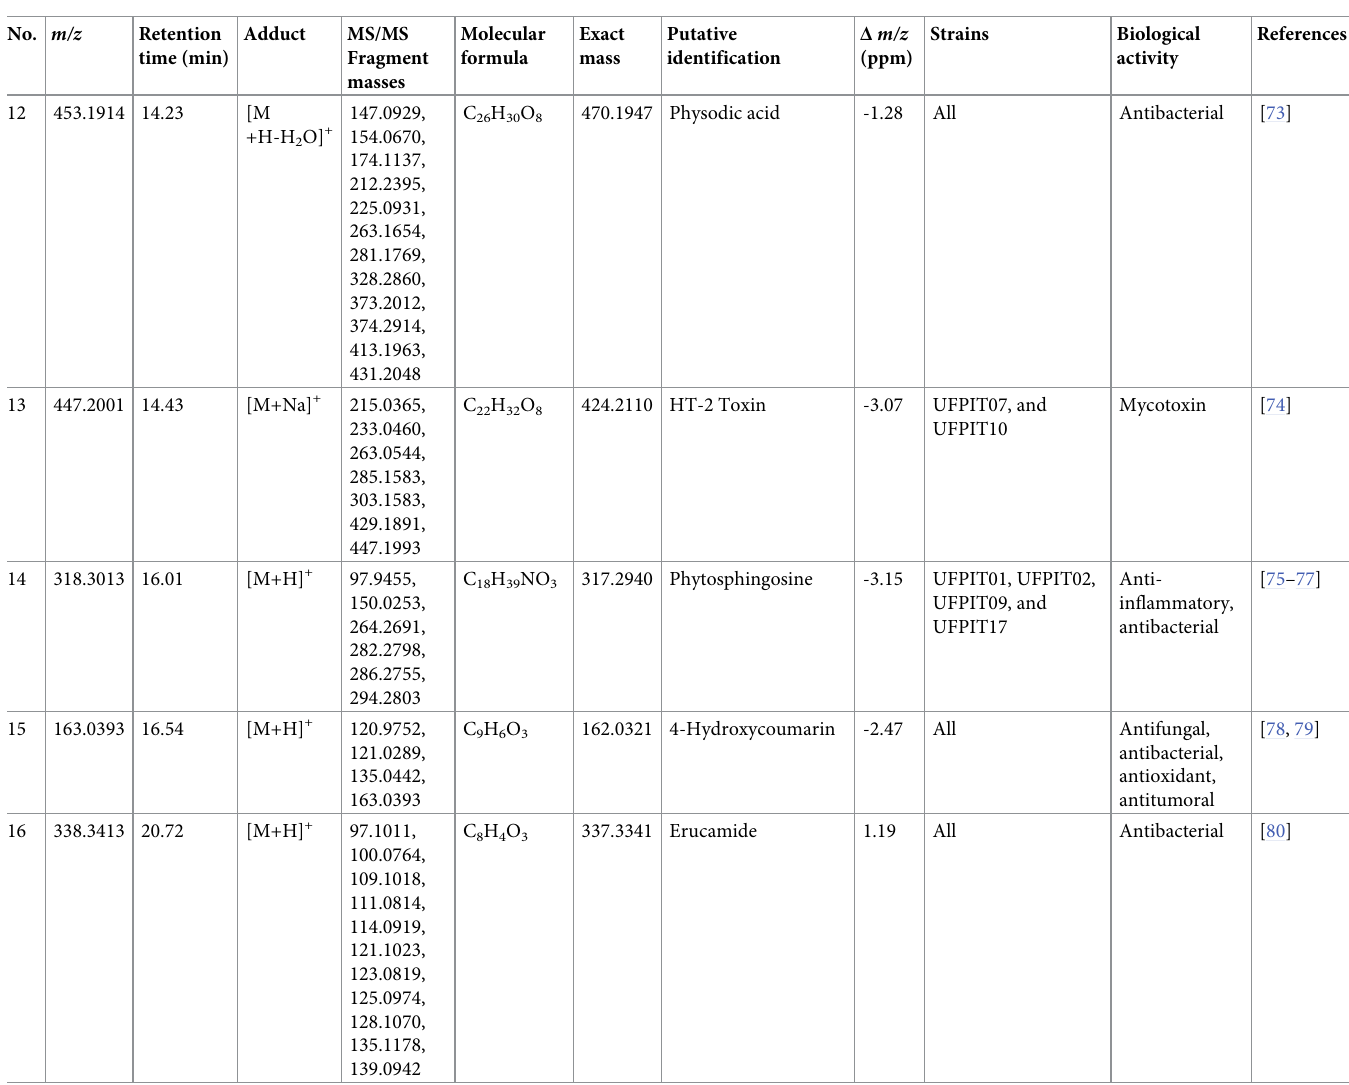
been isolated from the mycelium of Cordyceps sinensis [54]. The metabolite of m/z 118.0863 [M+H] + was detected in all Trichoderma spp. isolates and identified as glycine-betaine (Table 1, metabolite 2), presenting in the MS/MS spectrum the fragment of m/z 59.0705 corre- sponding to (CH ) N + [55]. Betaines are naturally occurring metabolites fundamental to the 3 3 mitigation of osmotic stress in plants and macro- and microorganisms [55]. The metabolite of m/z 138.0553 [M+H] + was identified as trigonelline (Table 1, metabolite 3) and was detected in T . longibrachiatum (UFPIT02), Trichoderma sp. T2 (UFPIT05), T . koningiopsis (UFPIT07), Trichoderma sp. T5 (UFPIT11), Trichoderma sp. T6 (UFPIT13), and T . koningiopsis (UFPIT19) isolates. The MS/MS spectrum was characterized by the fragment of m/z 92.0496 [ __ HCOOH] + , referring to the carboxylic acid group [56, 57]. This alkaloid is widely used in medicine to protect the liver and heart and to treat hypercholesterolemia [81]. and has already been identified in T . asperellum fermentation cultures